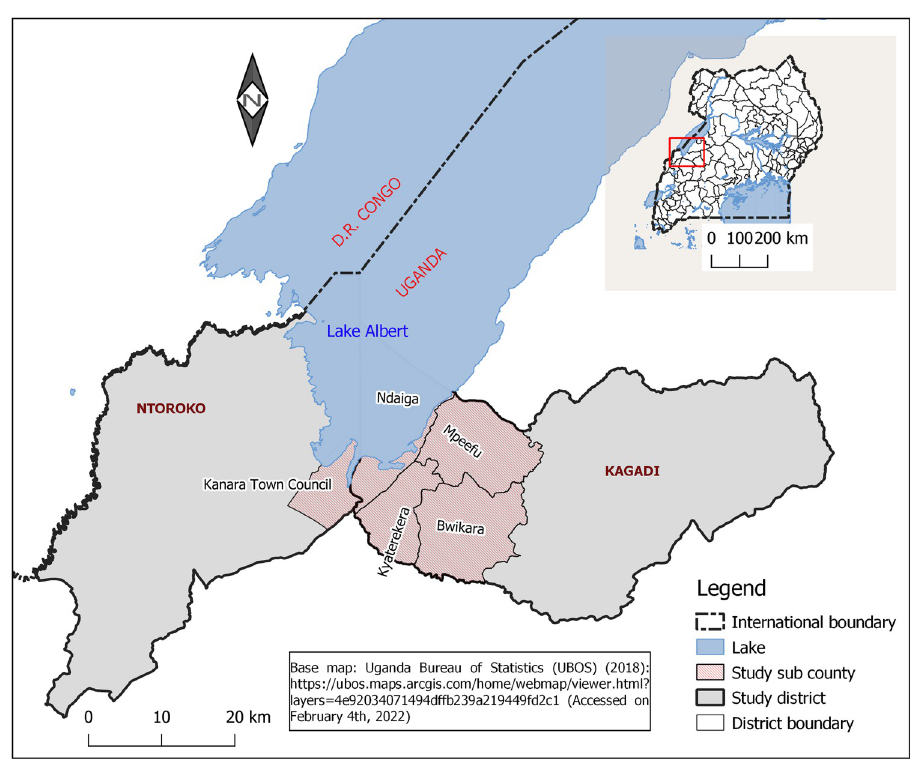
Fig 1. Study area showing districts and sub counties in the southern Lake Albert, Uganda. Source: Uganda Bureau of Statistics (UBOS) (2018): https://ubos.maps.arcgis.com/home/webmap/viewer.html?layers= 4e92034071494dffb239a219449fd2c1 (Accessed on February 4th, 2022).